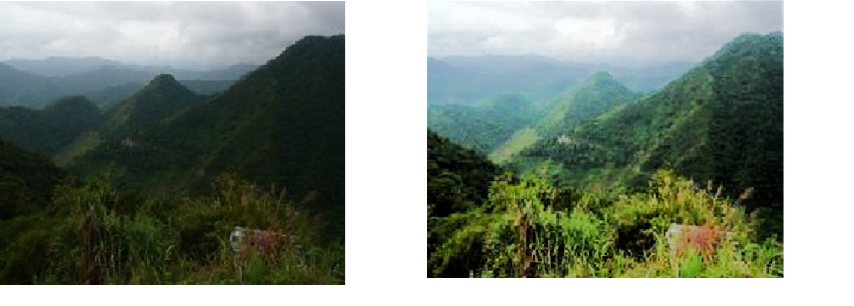
Figure 4. Images before and after Histogram